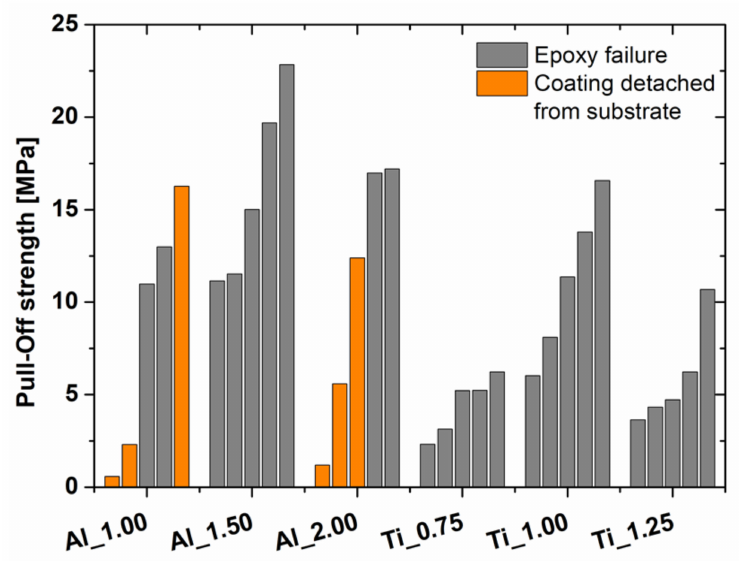
Figure 10. Pull-off strength of Al and Ti